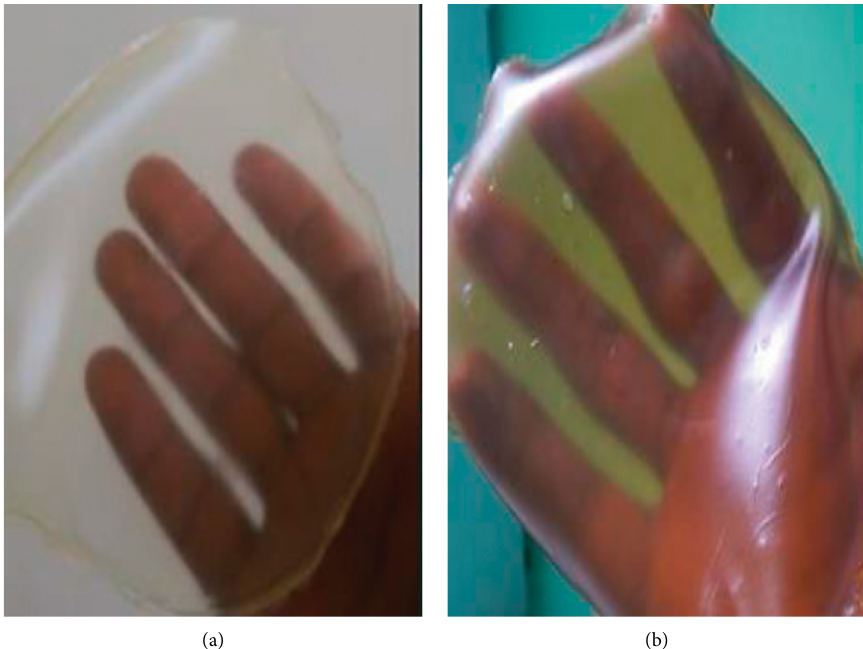
Figure 3: Color of packaging films without AM and with AM agent. (a) Film without AM. (b) AM packaging film.